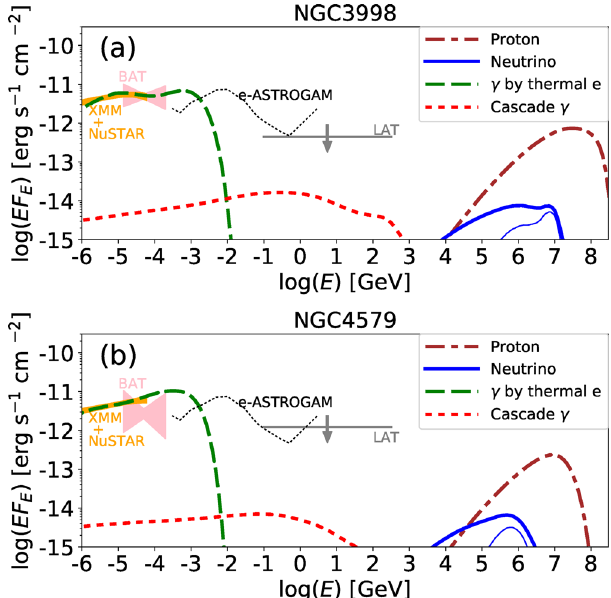
Fig. 2 Spectra for various particles from nearby LLAGN. The data by XMM-Newton & NuSTAR (orange regions; with a systematic error of 10%), Swift BAT (pink regions with 90% con fi dence levels), and Fermi LAT (downward arrows; upper limits with 95% con fi dence levels) are obtained from Ref. 34 , Ref. 112 , and Ref. 40 , respectively. a Spectra for photons from thermal electrons (dashed lines), nonthermal protons (dotted-dashed), total neutrinos (thick-solid), p γ neutrinos (thin-solid), and photons by electromagnetic cascades (thick dotted) for NGC 3998. We use M = 8.1 × 10 8 M ⊙ 113 , _ m ¼ 2 : 1 ´ 10 (cid:3) 3 , and D L = 14.1 Mpc. The thin-dotted line is the sensitivity curve of e-ASTROGAM with 1-yr integration 41 . b Same as ( a ), but for NGC 4579. We use M = 7.2 × 10 7 M ⊙ 101 , _ m ¼ 8 : 0 ´ 10 (cid:3) 3 , and D = 16.4 Mpc. The NuSTAR data is not smoothly connected to the BAT L data, and given the huge statistical error bars in the BAT data, we ignore the BAT